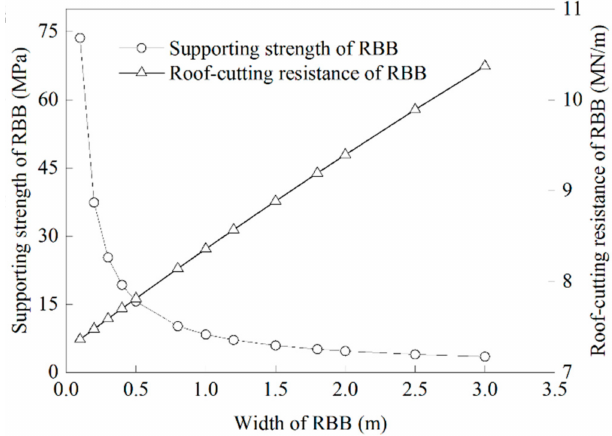
Figure 7. Roof-cutting resistance and support strength of the roadside backfill body (RBB) with respect to RBB